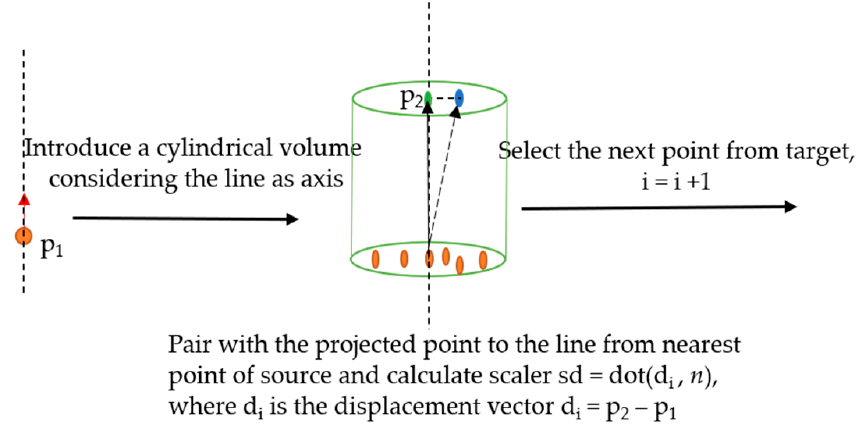
Figure 6. Sketch of the P2P_AlongNV distance calculation.